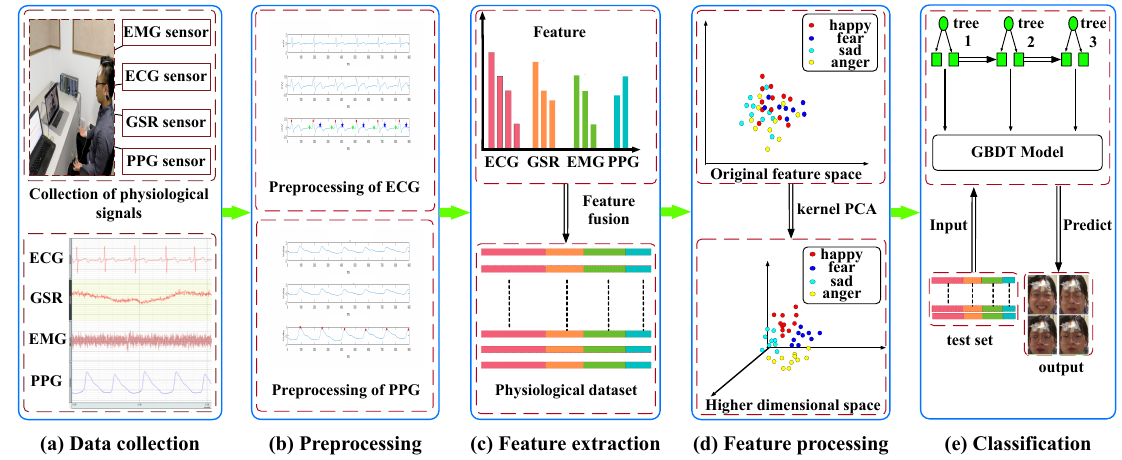
Figure 1. The process of emotion recognition